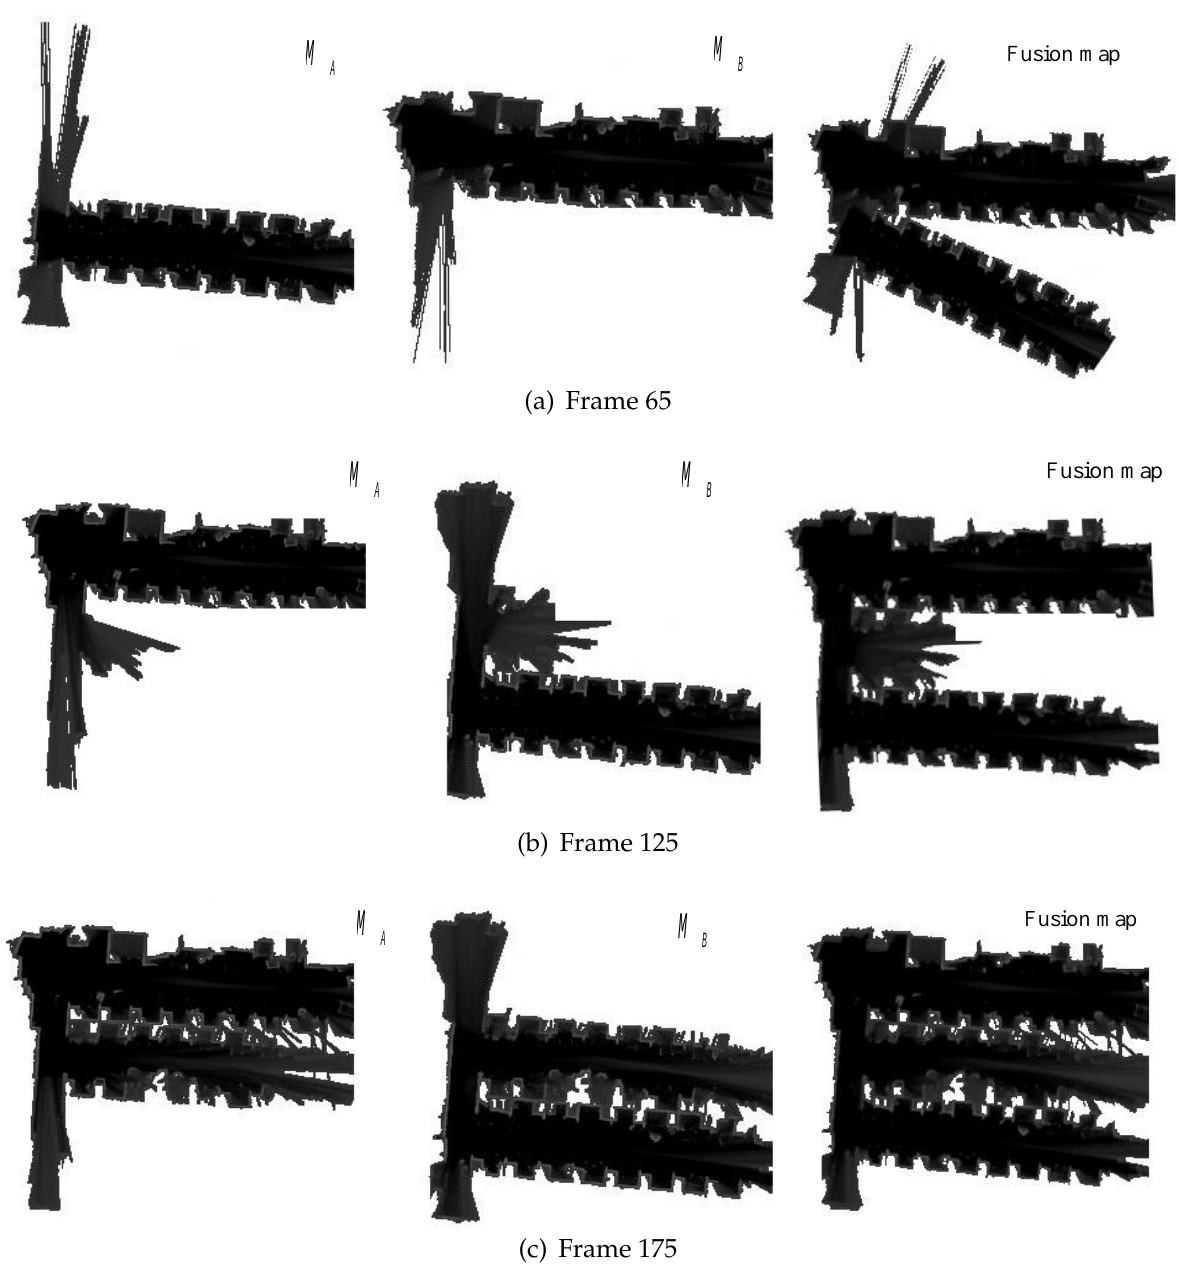
Figure 10. Map merging process